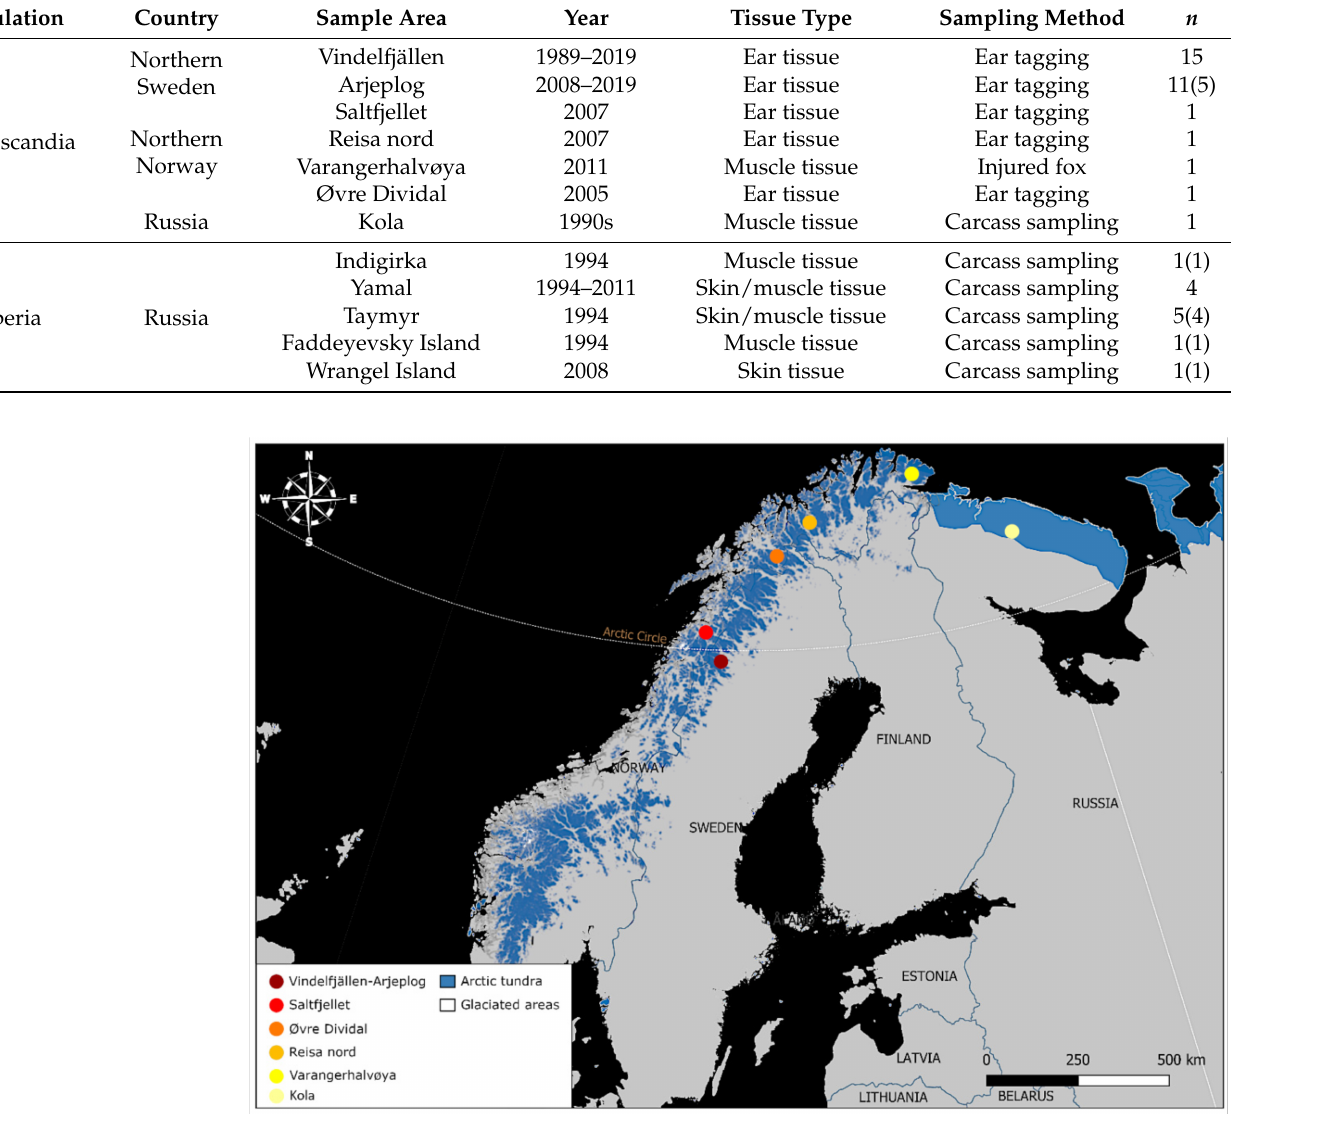
Figure 2. Map showing the distribution of Arctic tundra habitat (Scandinavia: alpine tundra [60]; Kola: oro-arctic tundra [61]) in relation to study sample areas in Vindelfjällen-Arjeplog, Saltfjellet, Øvre Dividal, Reisa nord, the Varanger Peninsula, and the Kola